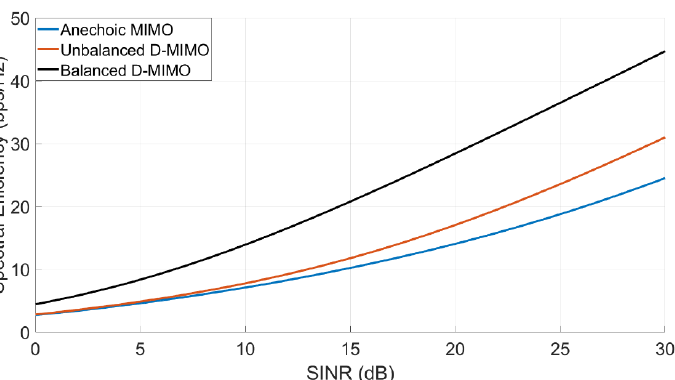
Figure 7. Spectral efficiency for the anechoic MIMO (blue line), unbalanced D-MIMO (red line) and balanced MIMO (black line). For each value of SINR, the spectral efficiency is averaged over the 101 frequency samples.